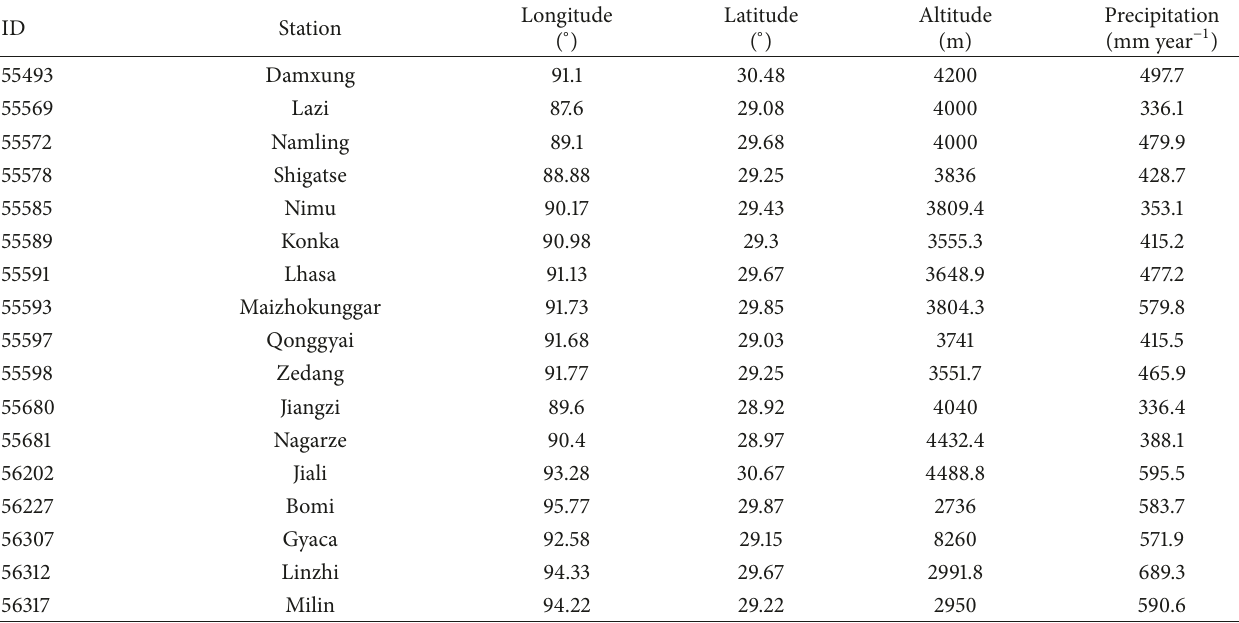
Table 1: Geographic information and multiannual mean precipitation for the 17 meteorological stations within the Yarlung Zangbo River Basin. The multiannual mean precipitation values were calculated from daily meteorological data from 2001 to 2014.